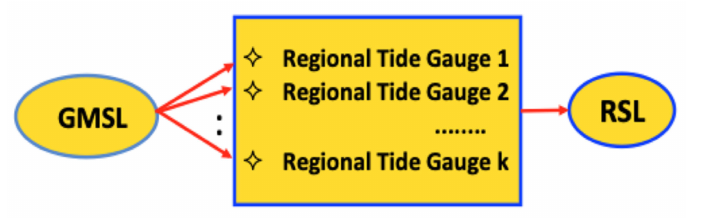
Figure 5. Pathway diagram of the Generalized Additive Model (GAM) to model the relationship between GMSL to RSL (Regional Sea Level) via select tidal gauges near each region of interest (e.g., NYC and Long Island, Miami, New